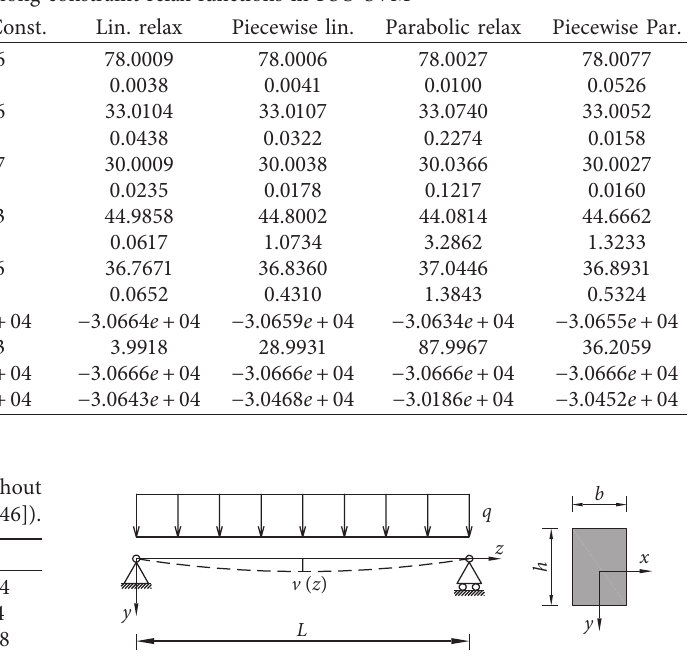
Table 2: Numerical example 2: comparison among PSO-SVM with different relax constraint functions (check Appendix and [46]). Comparison among constraint relax functions in PSO-SVM Design Var.